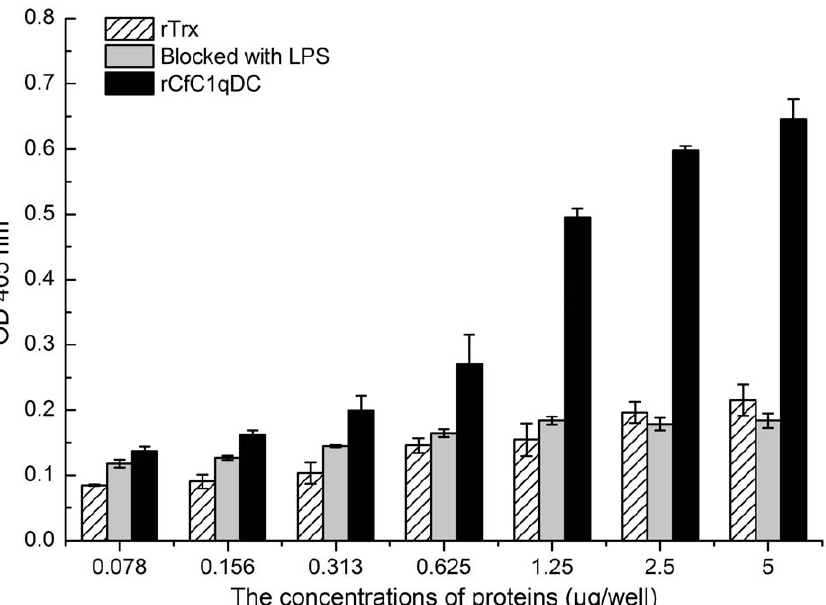
Figure 7. The inhibition effect of LPS in the rCfC1qDC and human heat-aggregated IgG interaction. Results are representative of average three such experiments.